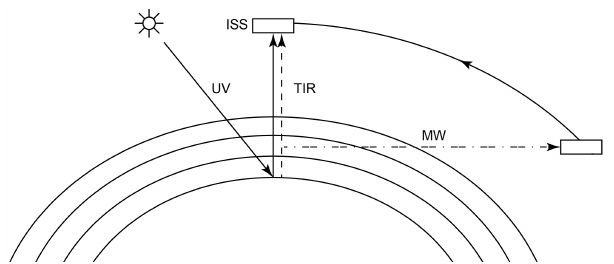
Figure 1. Geometries used for observation: nadir (UV and TIR) and limb